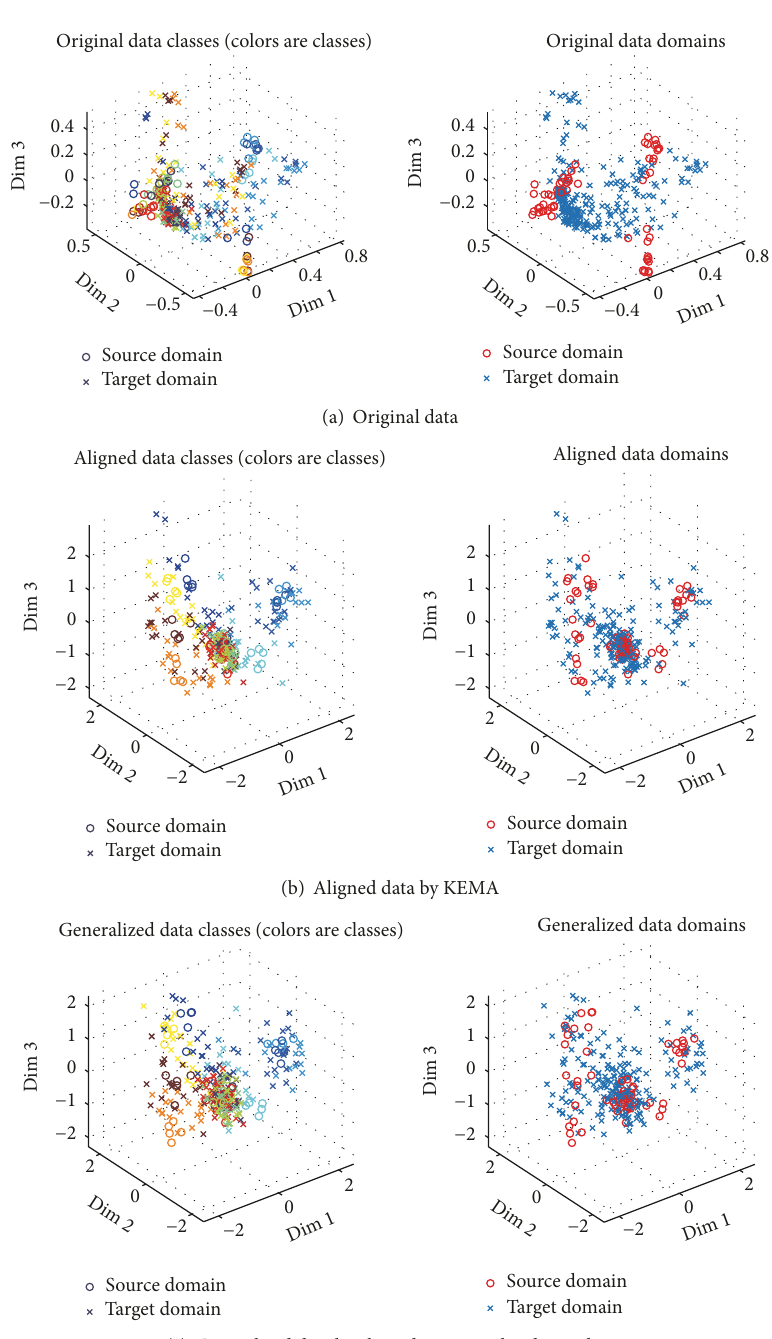
Figure 9: Examples of the three first dimensions of the original, aligned, and generalized data space. The left panel shows data distributions of two domains per class while the right panel shows the data distributions of all classes per domain.